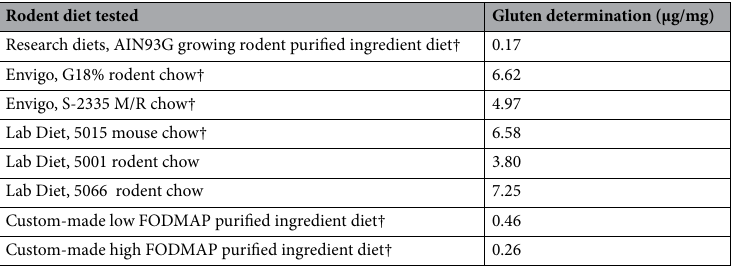
Table 3. Gluten content of commercially available and custom-made rodent diets. All samples analyzed as n = 3, except those marked with † denoting analysis as n =